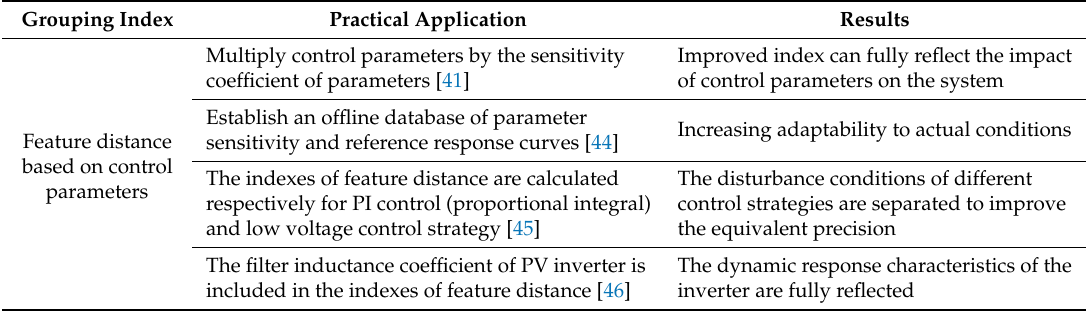
Table 4. The index of feature distance based on the control